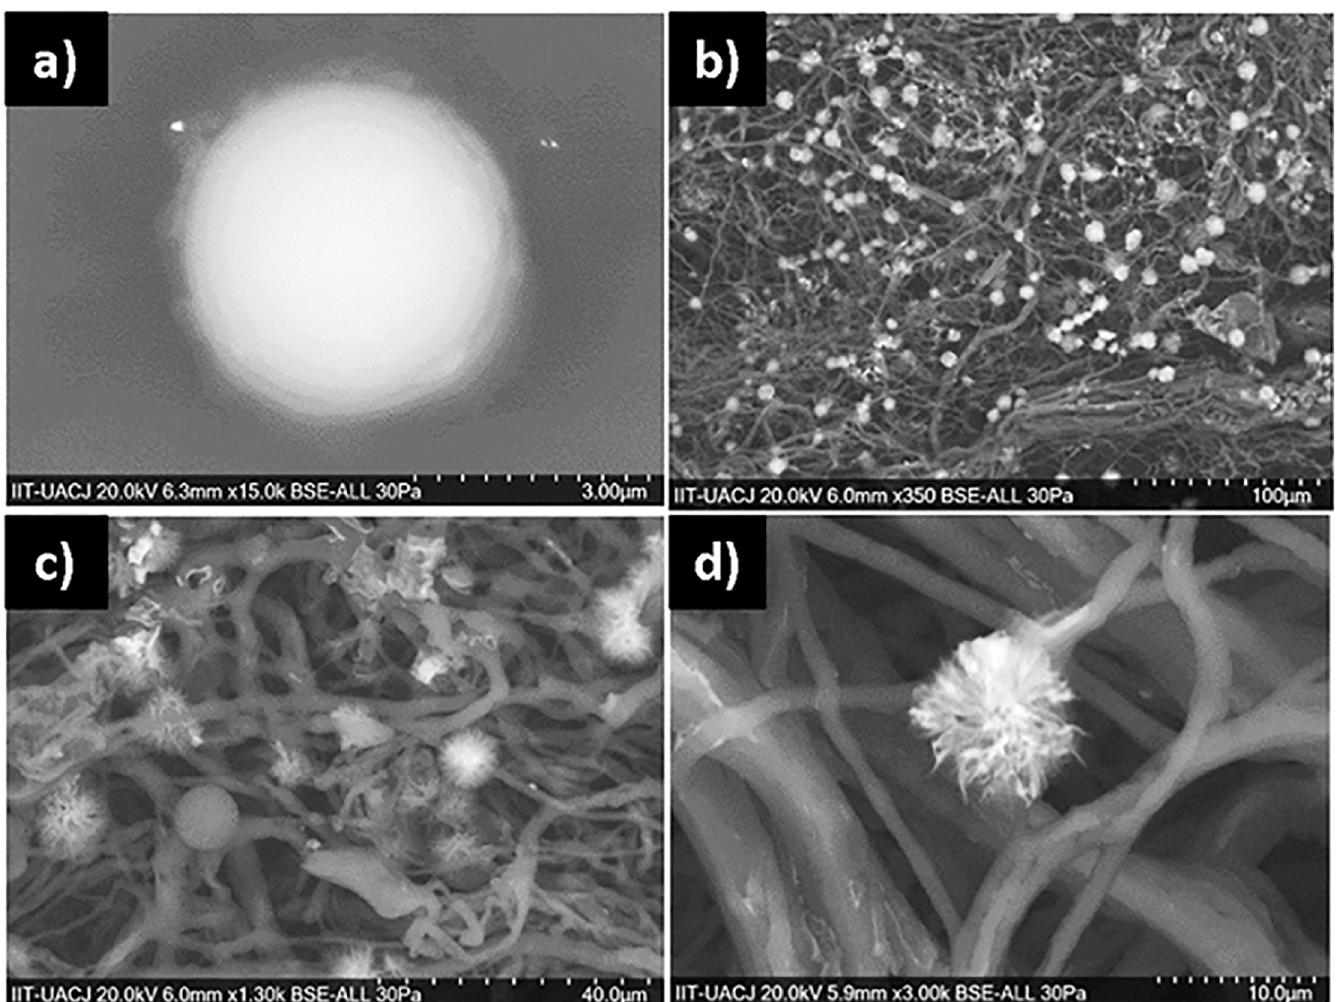
Fig 5. Inhibition effect of PCL-CuONPs against C. albicans. a) and b) are images for C. albicans exposed to plain PCL, and c) and d) are images of C. albicans exposed to PCL-CuONPs at 200 mM.